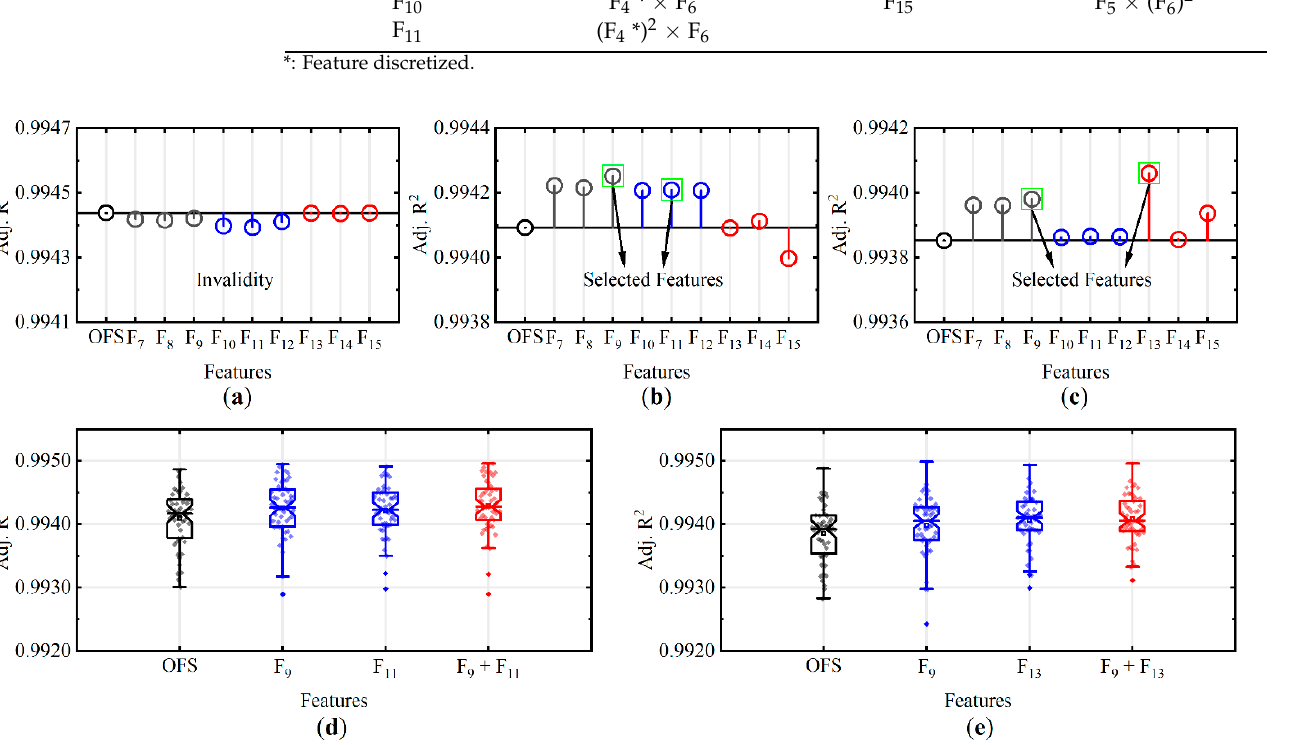
Figure 5. Performance comparison of the base learners based on feature sets composed of the original feature set (OFS) and different synthetic features: ( a ) result of k-nearest neighbors regression (KNN); ( b ) result of random forests (RF); ( c ) result of LightGBM; ( d ) boxplot for the result of RF; ( e ) boxplot for the result of LightGBM.